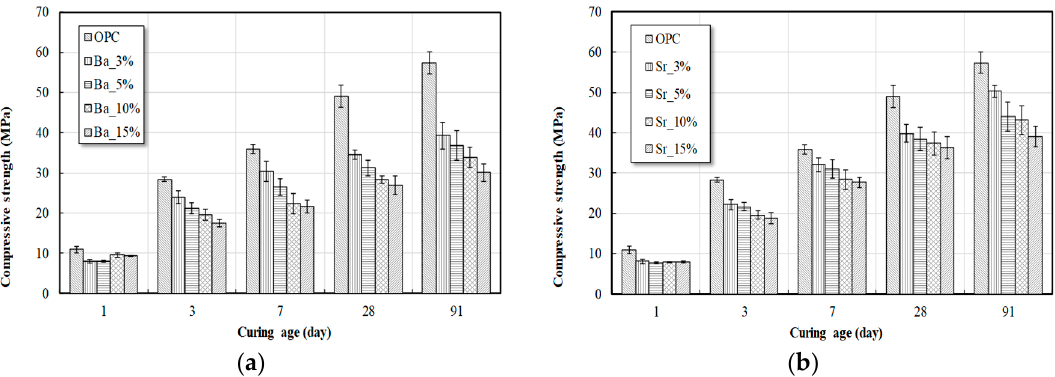
Figure 9. Effects of addition mixing ratio of PCM on compressive strength—( a ) PCM-Ba; ( b ) PCM-Sr.